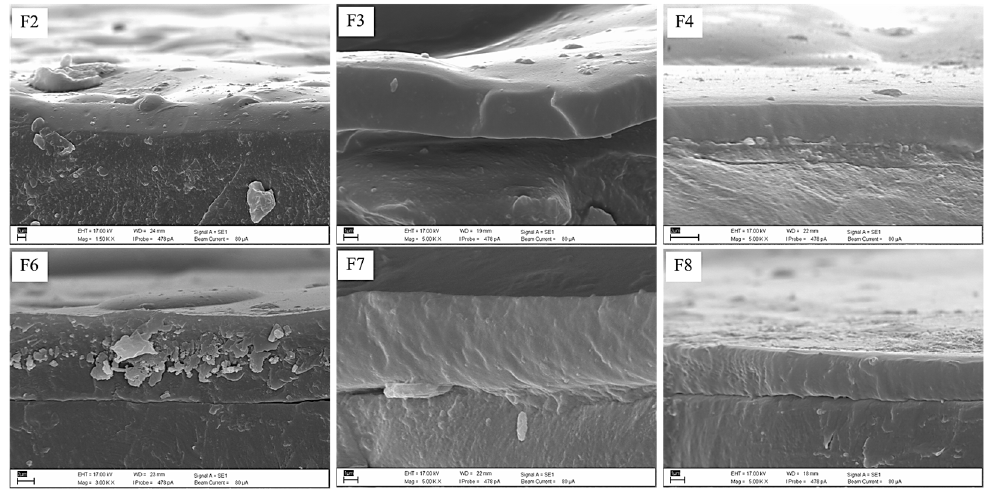
Figure 3. SEM micrograph cross section images of six self-disinfection coating formulas (F2–F4 and F6–F8) on acrylic surfaces.